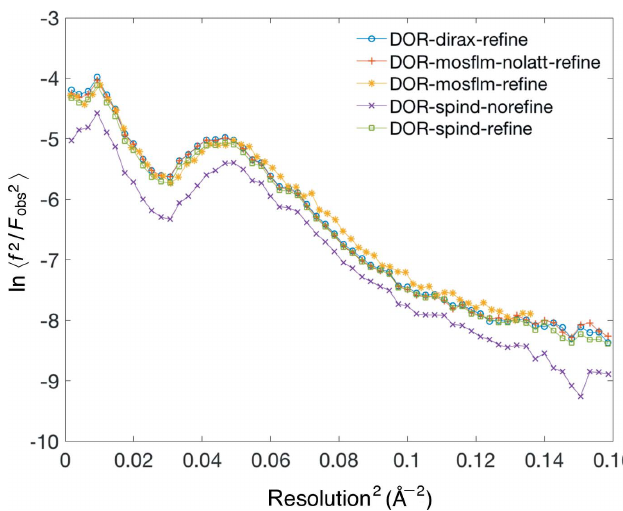
Figure 6 Wilson plots for the merged DOR data sets from different indexing methods. The linearity in the 0.06 to (cid:8) 0.13 A˚ (cid:3) 2 region and the consistency between all indexing methods confirm the quality of the merged data